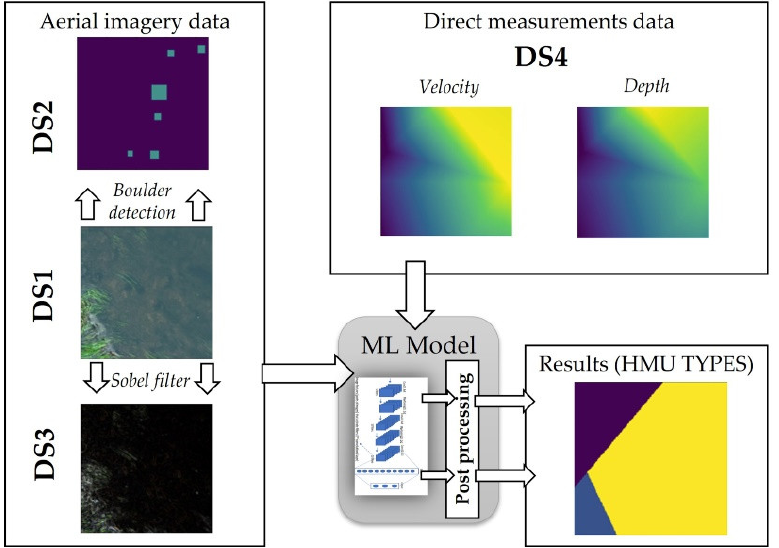
Figure 4. Generalized scheme of HMUs determination of ML model using data sources based on direct and indirect measurements.